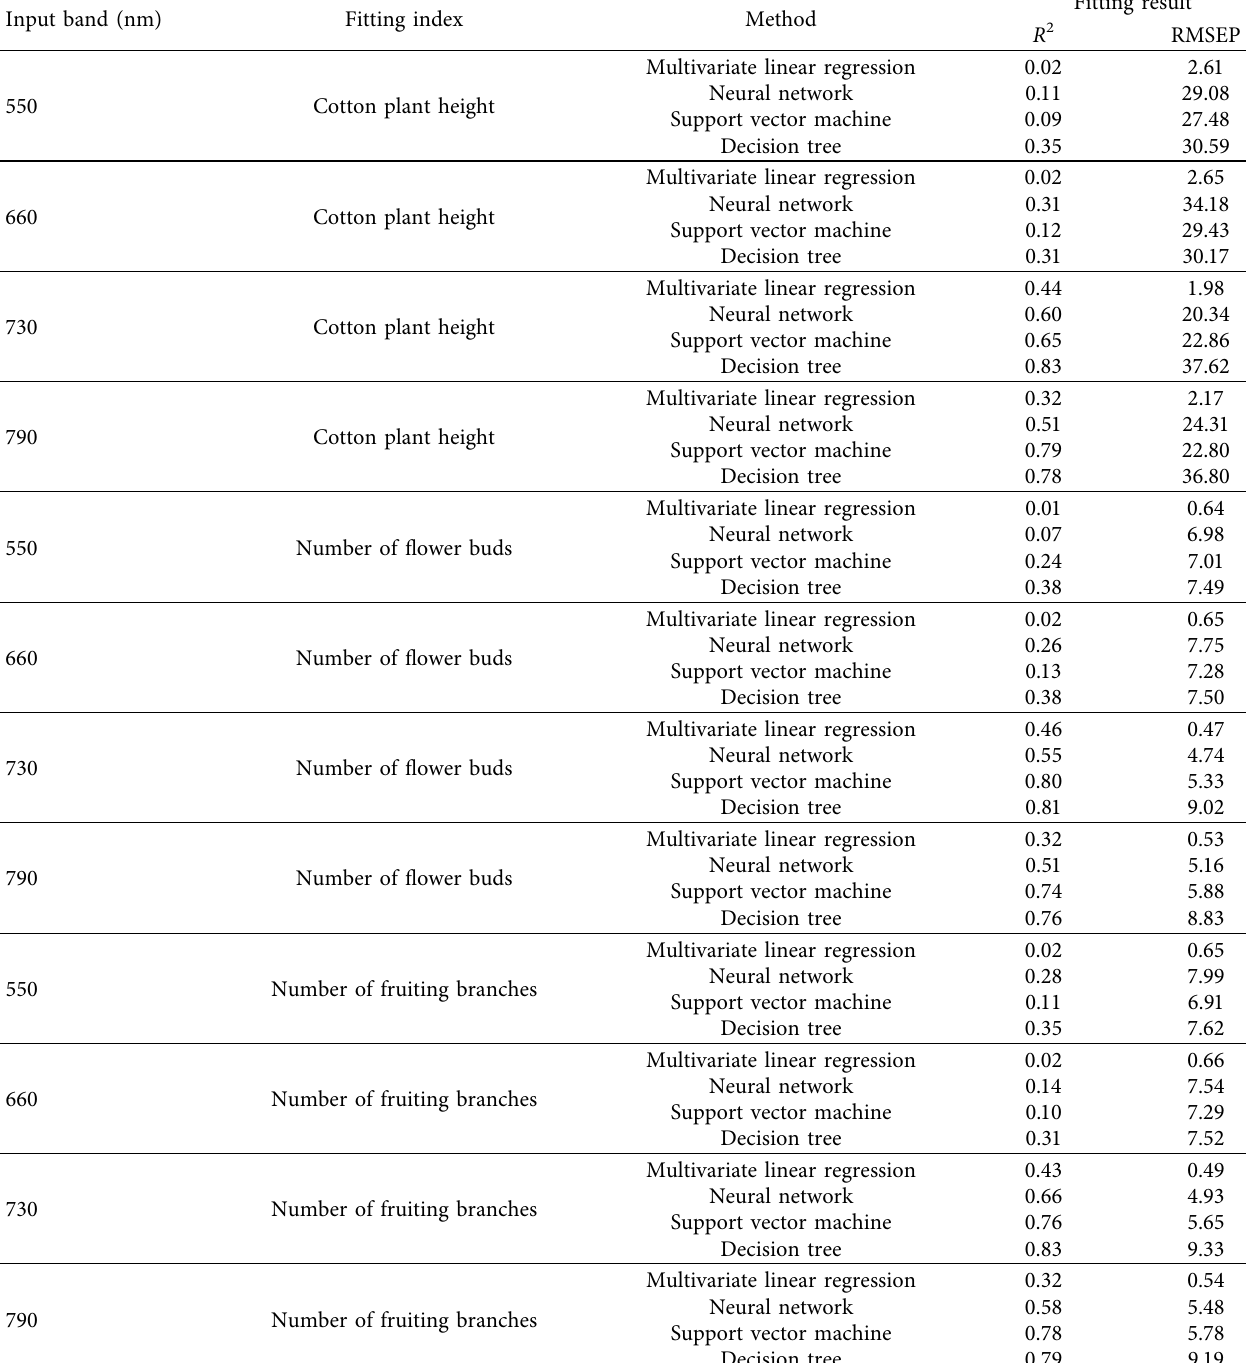
Table 1: Regression table of single band and the number of cotton plant height, flower buds, and fruiting branches. Input band